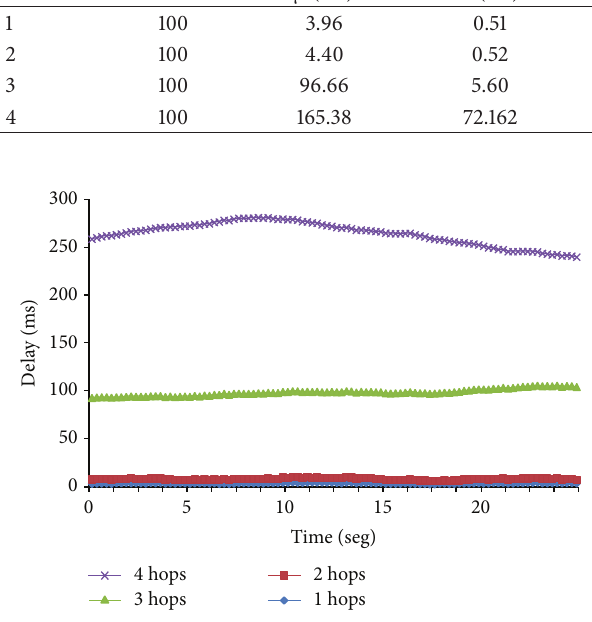
Figure 8: Delay of a multimedia stream of 600 kbps for different cluster diameters. Figure 9: Jitter of a multimedia stream of 600 kbps for different cluster